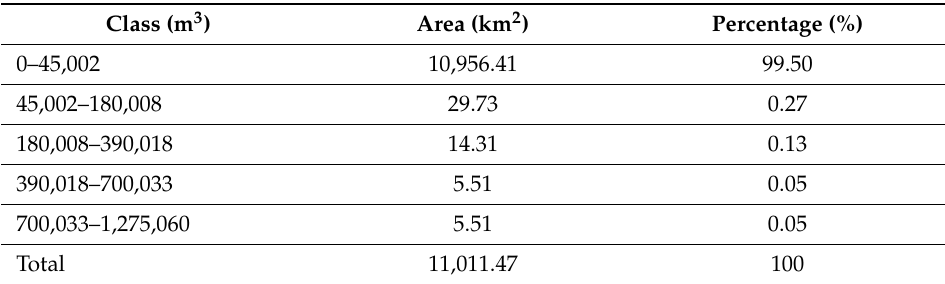
Table 15. Flow accumulation analysis for the Al-Shamal train pathway in Al-Qurayyat city in 2020.